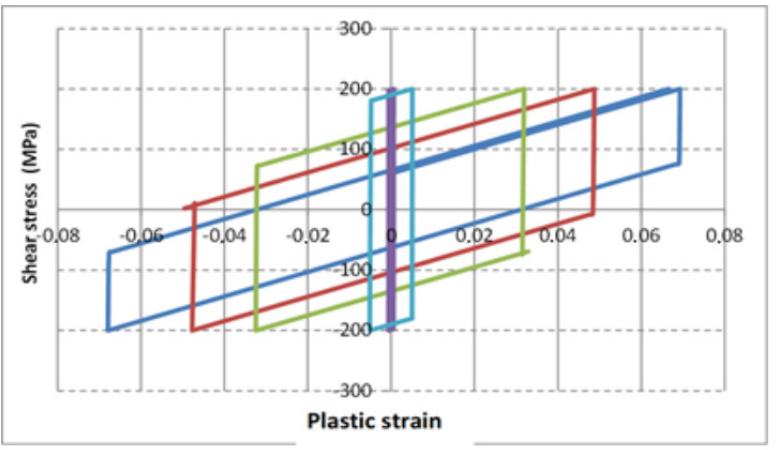
Figure 4. Shear stress τ a vs. plastic strain γ (blue: 1 cycle, red: 100 cycles, green: 200 cycles, magenta: 250 cycles, purple: 300 cycles).